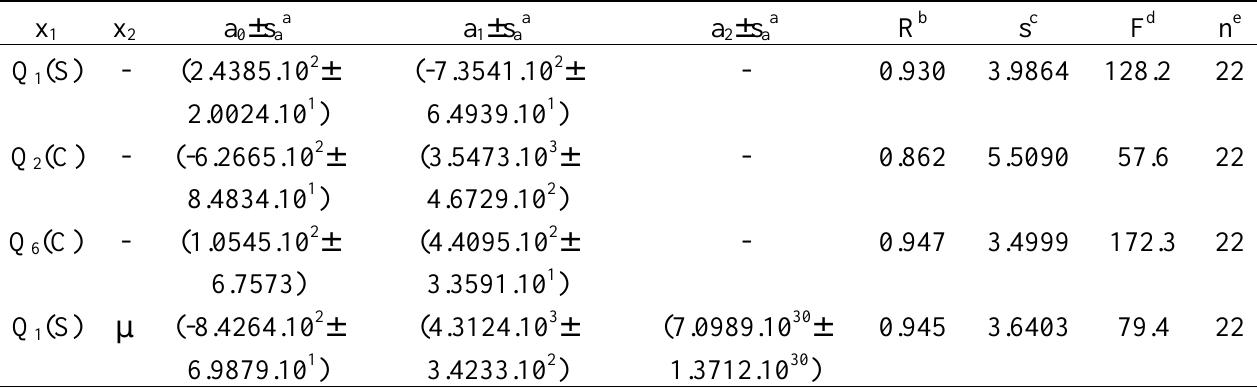
Table 3. Correlation analysis for experimental and theoretical